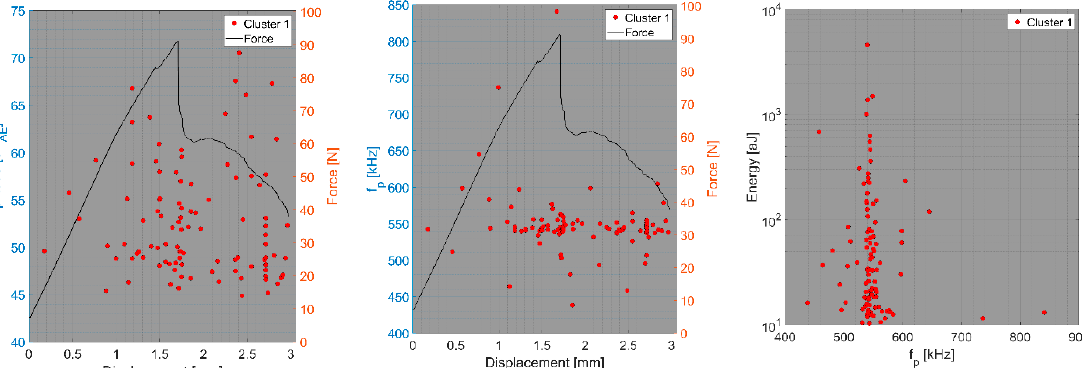
Figure 11. Clustering results for a CFB representative sample using a spectral clustering algorithm (DWC dataset).